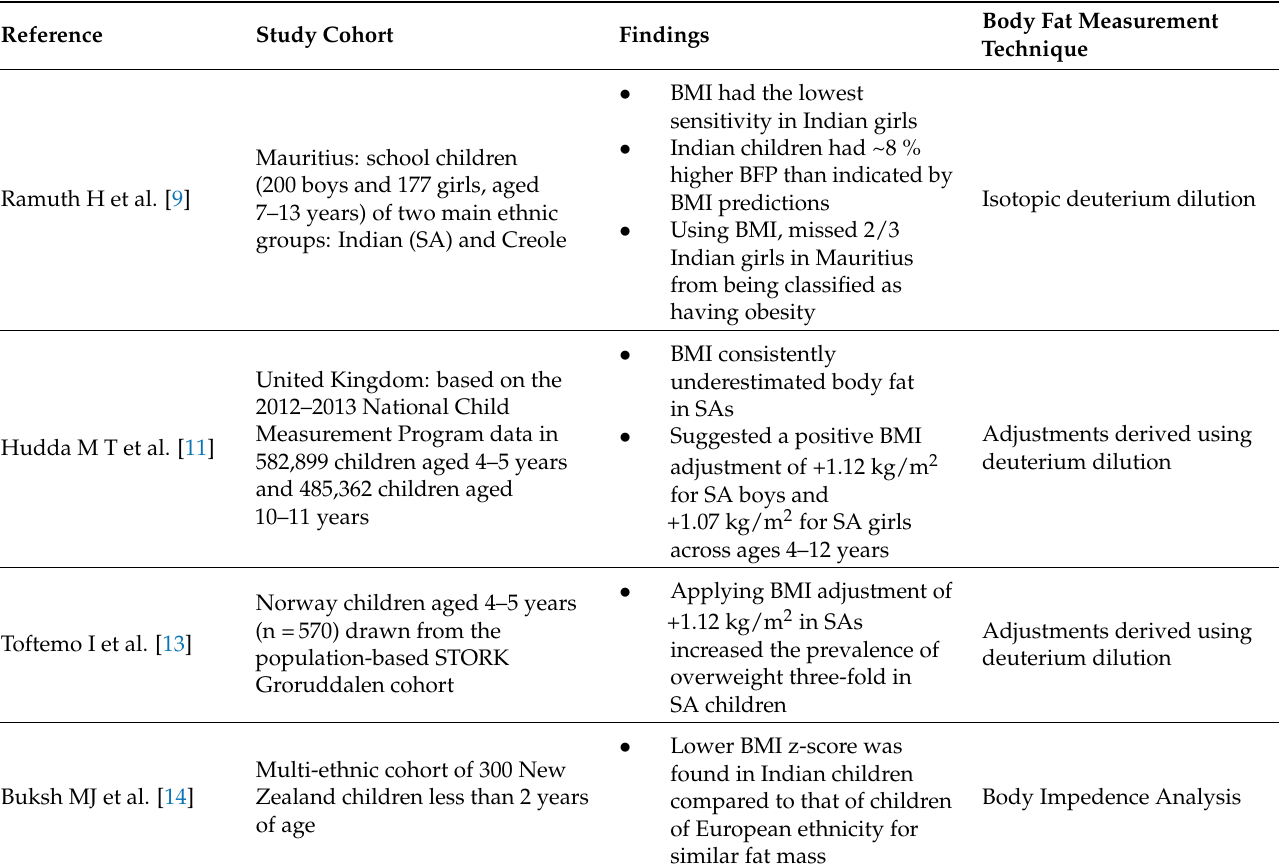
Table 1. BMI validity in evaluating BFP in SA children compared to that of Caucasian